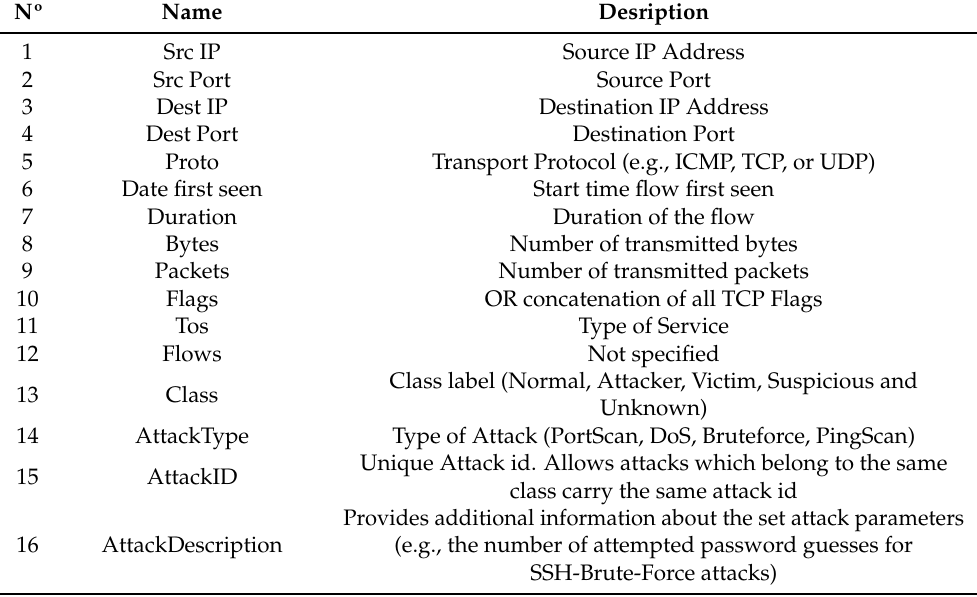
Table 1. Specification of the CIDDS-001 dataset features. Adapted from [8].